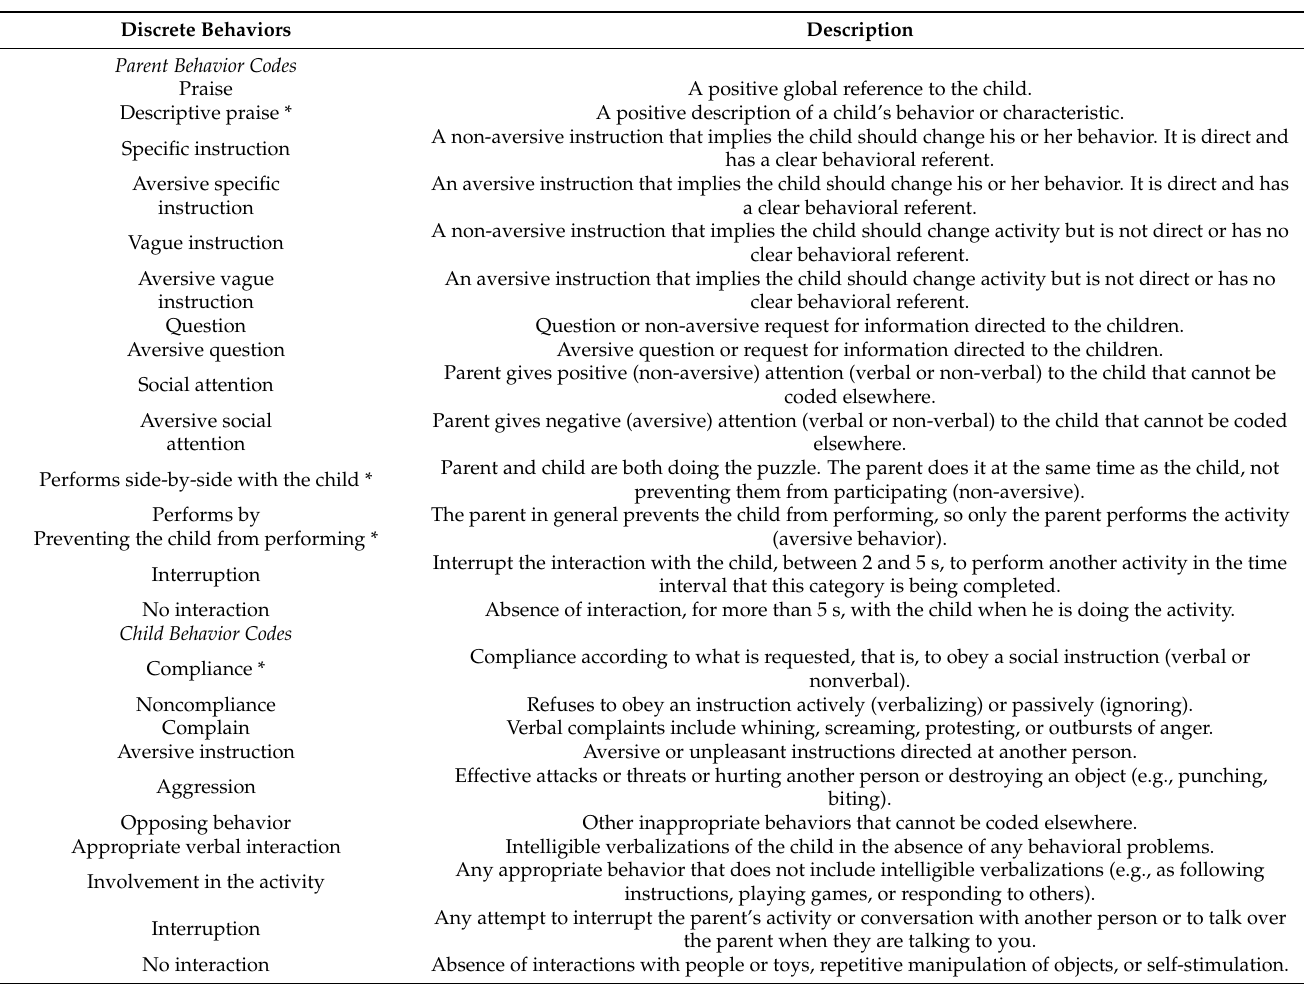
Table 1. Discrete behaviors used in the micro-analytic coding adapted from the FOS (Family Observation Schedule) and developed from a deductive approach based on the literature. Discrete Behaviors